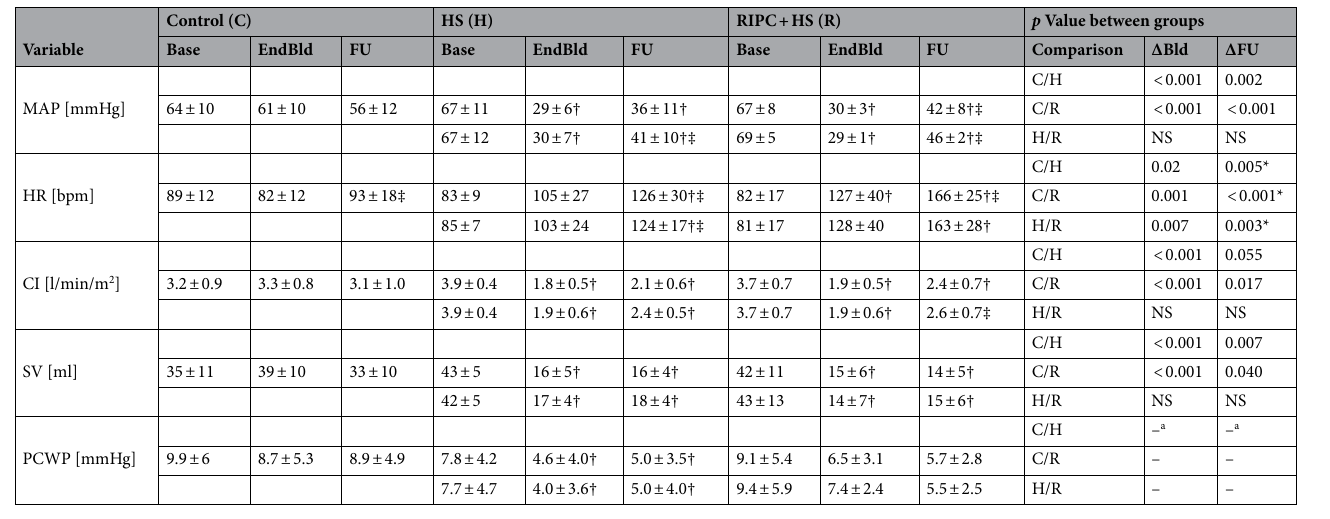
Table 1. Hemodynamic parameters. Data presented as mean ± SD. Numbers in first row of each parameter are for all animals. Numbers in second row of each parameter are only those that survived (6 h of follow-up: Controls, n = 7 at all time-points; HS, n = 13 at 2H, n = 10 at 4H, n = 9 at 6H; RIPC + HS, n = 8 at 2H and 4H, n = 5 at 6H). Normality was determined by Shapiro–Wilk (SW) test ( p > 0.1). Comparisons between baseline, end of bleeding [EndBld], and follow-up [FU] (mean over 7-h follow-up) within groups were performed by paired t-test with Bonferroni’s correction for multiple comparisons or Friedman’s test with pairwise comparisons as post-hoc test as appropriate (according to SW). Comparisons between groups (relates to all 7 h) were performed by analysis of variance (ANOVA) with Fisher’s least significance difference (FLSD) as post-hoc test or Kruskal–Wallis (KW) with Conover-Iman as post-hoc test. MAP = mean arterial pressure, HR = heart rate, CI = cardiac index, SV = stroke volume, PCWP = Pulmonary capillary wedge pressure. ΔBld = (EndBld-Baseline), ΔFU = (FU-EndBld), *ΔFU = (FU-Baseline). p < 0.05 considered significant and all tests 2-tailed. † p < 0.05 versus baseline; ‡ p < 0.05 versus EndBld; § not significant by ANOVA/KW.